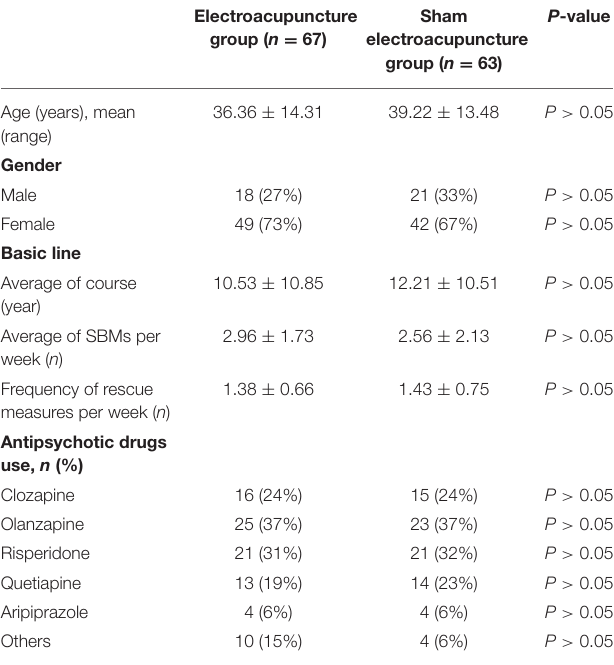
TABLE 1 | Summary of patient demographics and baseline